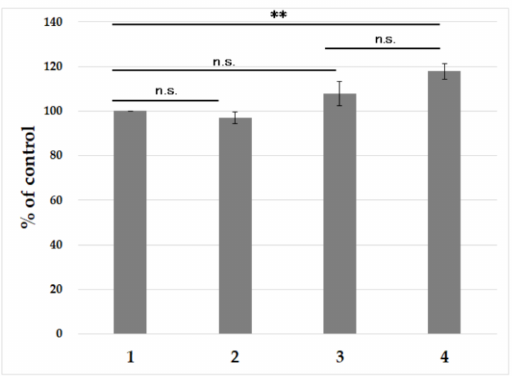
Figure 3. Effects of NTAPP on the culture medium. Group 4 (in which both cells and culture medium were NTAPP-irradiated) showed a significant increase in the proliferative capacity compared with the control (group 1) (in which neither cells nor culture medium was irradiated). Data are presented as means ± SE ( n = 4). ** indicates significant differences at p < 0.01.